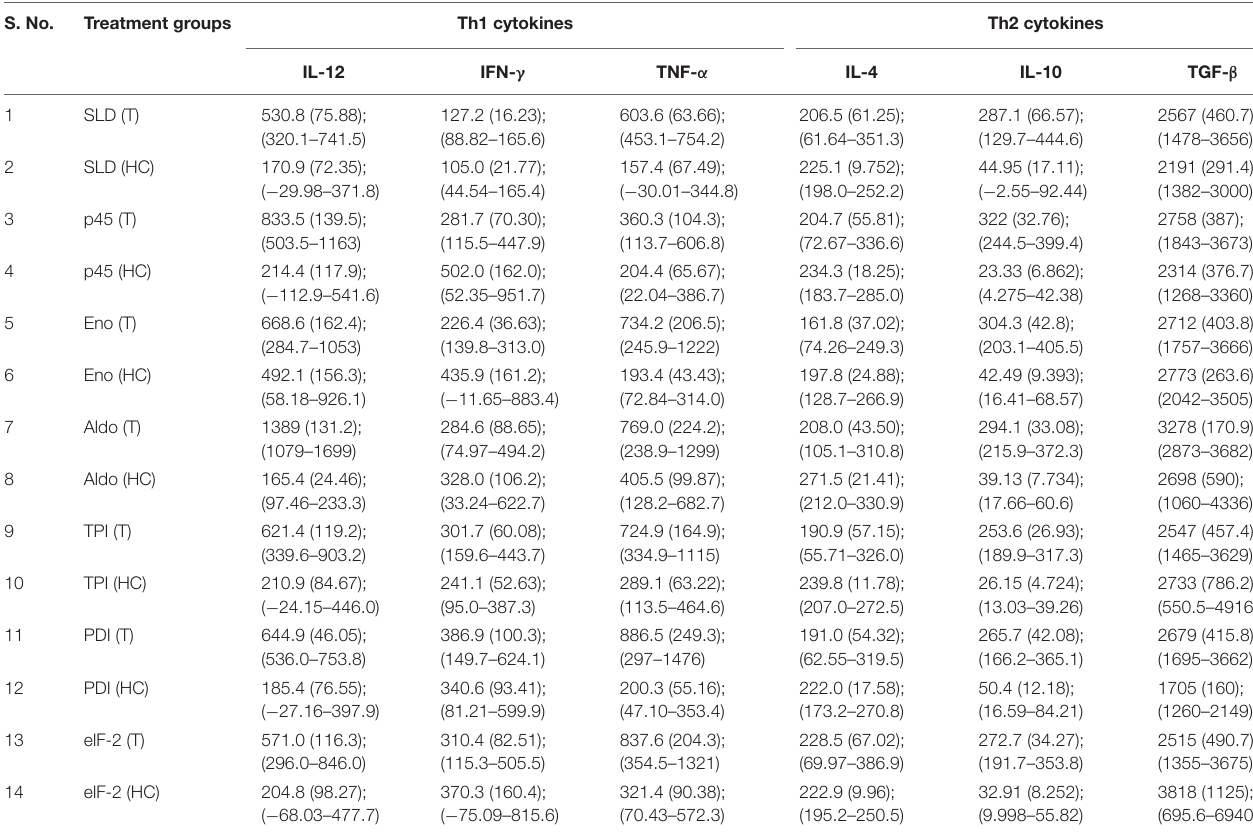
Values are displayed as mean (SE); (95% confidence